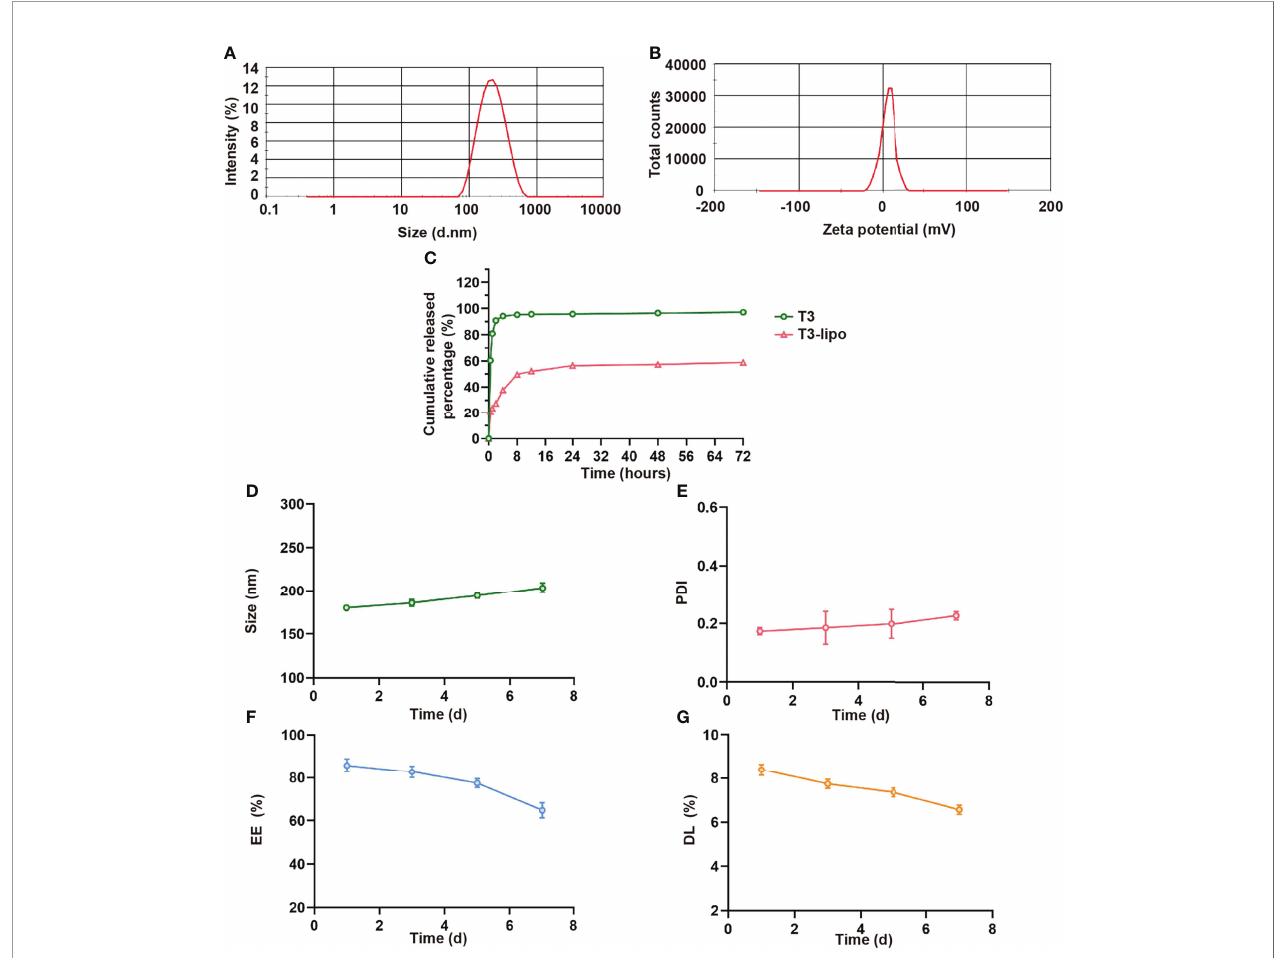
FIGURE 1 | Characterization of T3-lipo. (A) Size distribution of T3-lipo. (B) Zeta potential distribution of T3-lipo. (C) In vitro release pro fi les of T3 from T3-lipo in phosphate-buffered saline (PBS, pH = 7.4) over 72 h. (D – G) Stability of T3-lipo in particle size, polydispersity index (PDI), encapsulation ef fi ciency (EE), and drug loading (DL) values over 7 days at 4°C. Mean ± SD values were obtained from at least three independent experiments performed in